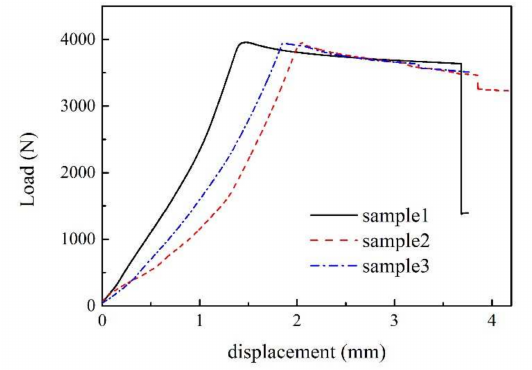
Figure 5. Load–displacement curves of three